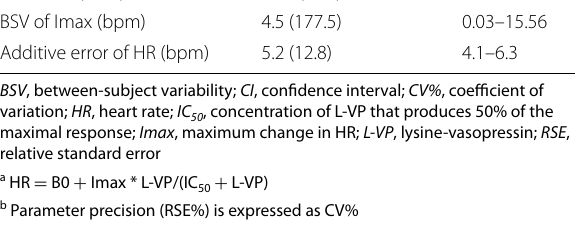
BSV , between-subject variability; CI , confidence interval; CV% , coefficient of variation; HR , heart rate; IC 50 , concentration of L-VP that produces 50% of the maximal response; Imax , maximum change in HR; L-VP , lysine-vasopressin; RSE , relative standard